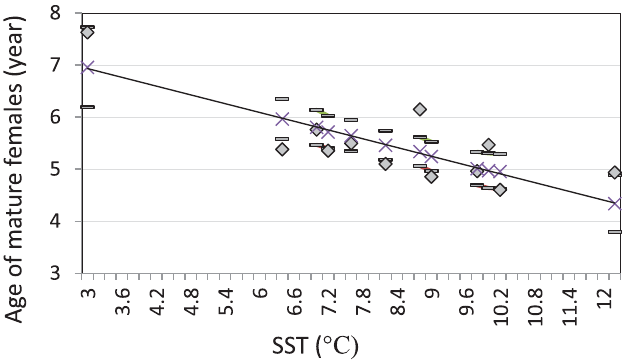
Fig. 6. Model for the dependence of the mean age of mature white fi sh on sea surface temperature (SST) in June in Valassaaret. The model predicts a linear trend (continuous line) between the mean age of mature females of the year class and June SST in the third summer of the year class. The 95% con fi dence limits of the mean (broken lines) and observations (diamond) are